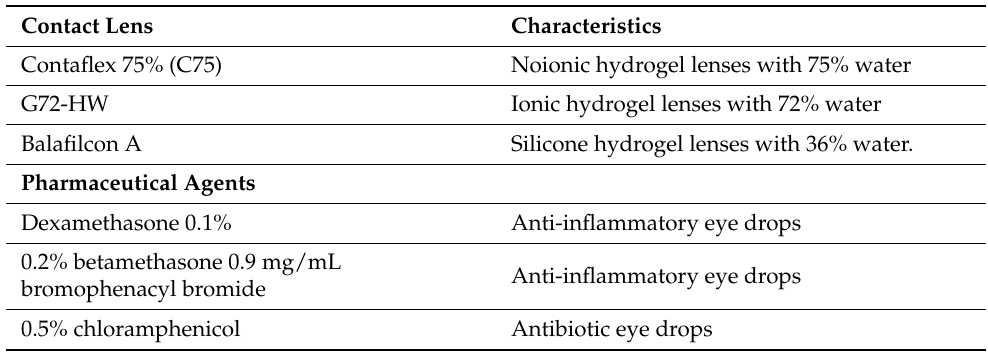
Table 1. Characteristics of the contact lenses and pharmaceutical